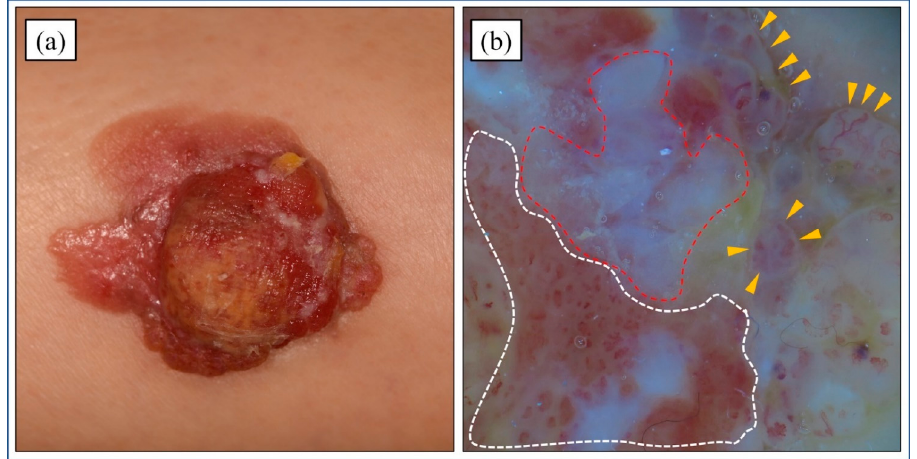
Figure 1. Clinical and dermoscopic findings. ( a ) A brown dome-shaped nodule of 30 × 35 mm is observed on the right thigh. The erythema around its margins is asymmetric. ( b ) Dermoscopic examination shows whitish globular structures (red dotted line). Polymorphous vessels with a whitish negative network on a light brown background are also observed (yellow arrowheads). The vessels are more conspicuous and irregularly shaped (white dotted line).